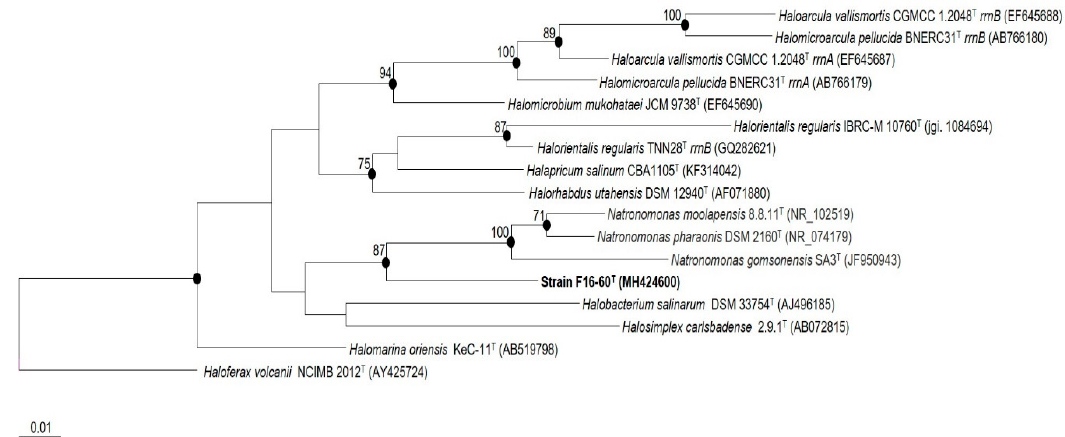
Figure 1. Maximum-likelihood phylogenetic tree based on 16S rRNA gene sequence of strain F16-60 T and related members of the order Halobacteriales . Filled circles indicate branches that were supported by the neighbour-joining, maximum-parsimony, and maximum-likelihood algorithms. Bootstrap values higher than 70% are indicated at branch-points. Sequence accession numbers are shown in parentheses. Bar: 0.01 substitutions per nucleotide position. The species Haloferax volcanii NCIMB 2012 T was used as an outgroup.